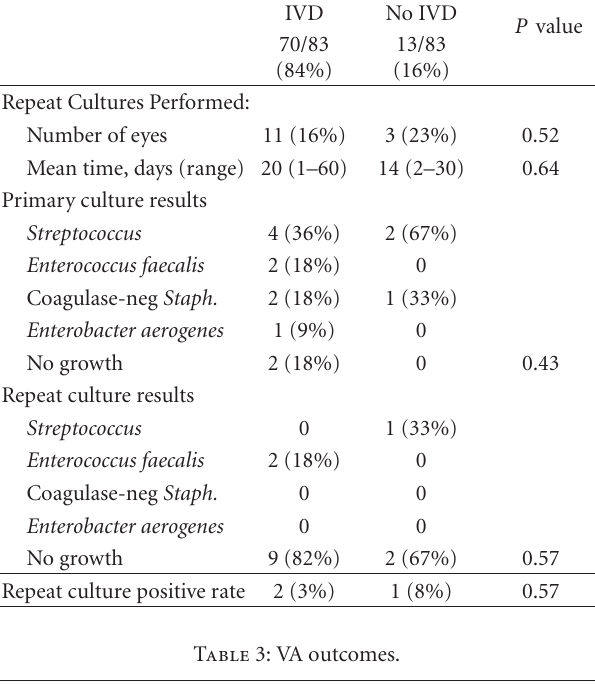
Table 1: Baseline demographics, clinical presentation, and initial Table 2: Repeat culture results.